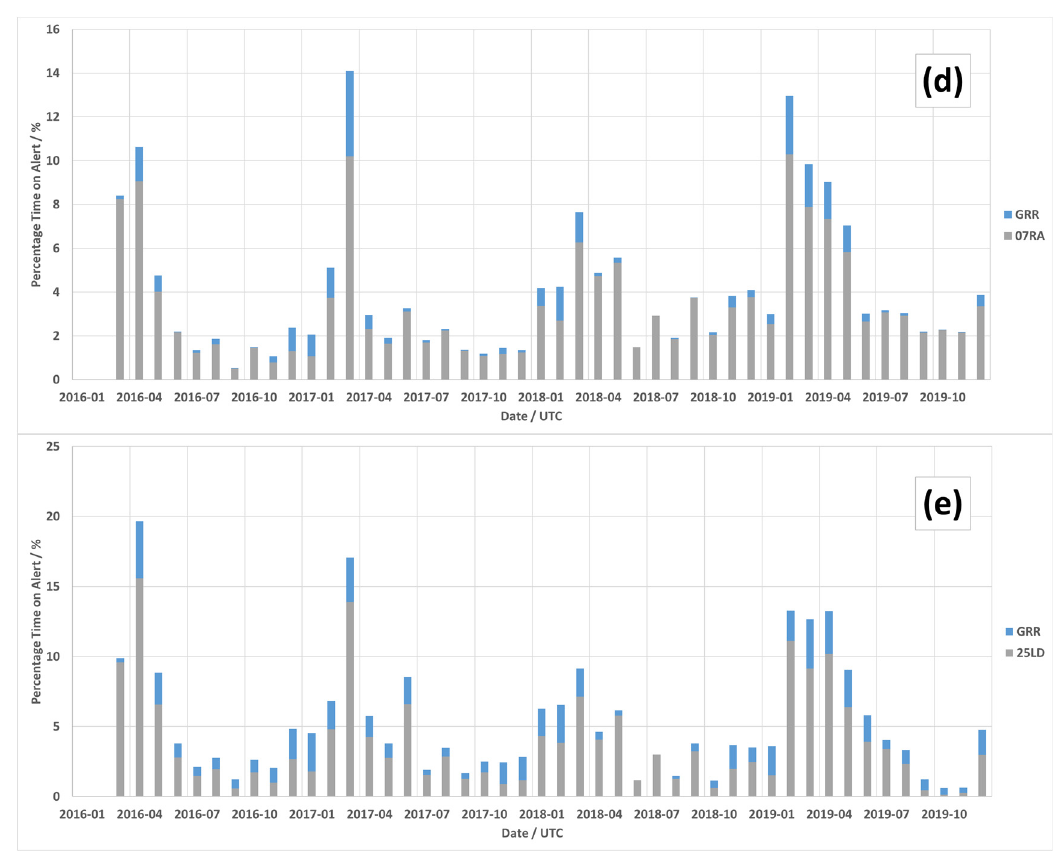
Figure 5. Effect of GRR on GLYGA alert duration over the 5 main runway corridors: ( a ) 07LA, ( b ) 25RA, ( c ) 07RD, ( d ) 07RA, ( e ) 25LD.